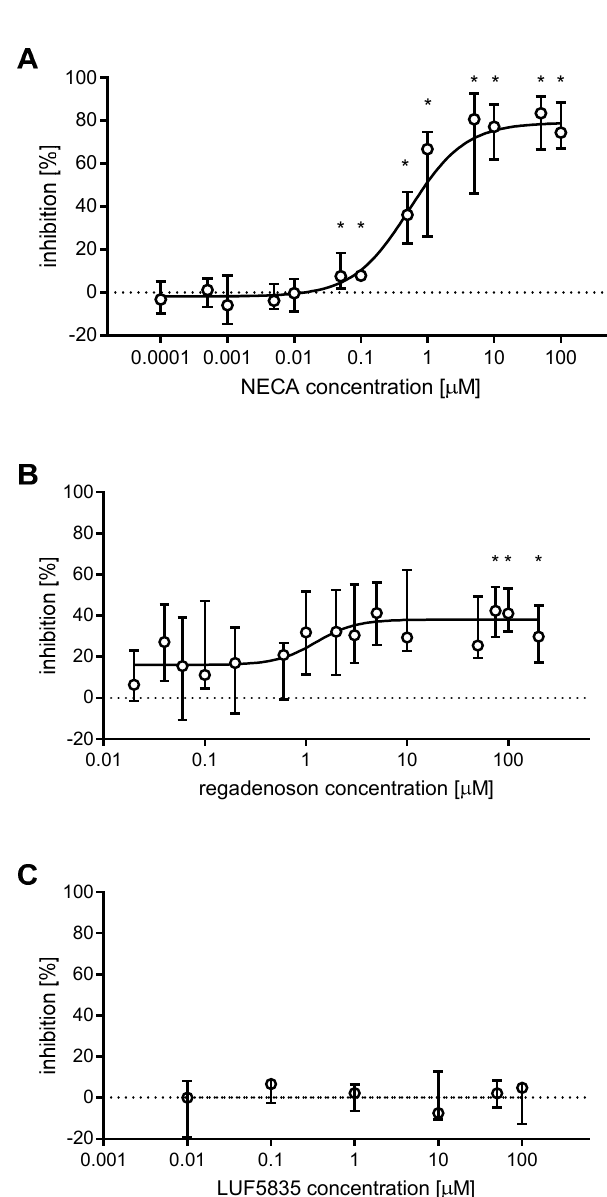
Figure 1. Inhibition of ADP-induced platelet aggregation by AR agonists. Data shown as median ± interquartile ranges, with dose-response plots based on the AUC values using non-linear regression analysis (NECA ( A ) n = 5, regadenoson ( B ) n = 5; LUF5834 ( C ) n = 4). Changes in platelet aggregation were measured in whole blood in response to 10 μ M ADP after 3 min preincubation at 37 °C with AR agonist. Data was analysed for statistical significance using repeated measures ANOVA with Geisser-Greenhouse correction and Holm-Sidak’s multiple comparisons test. * indicates statistical significance p < 0.05 or lower.